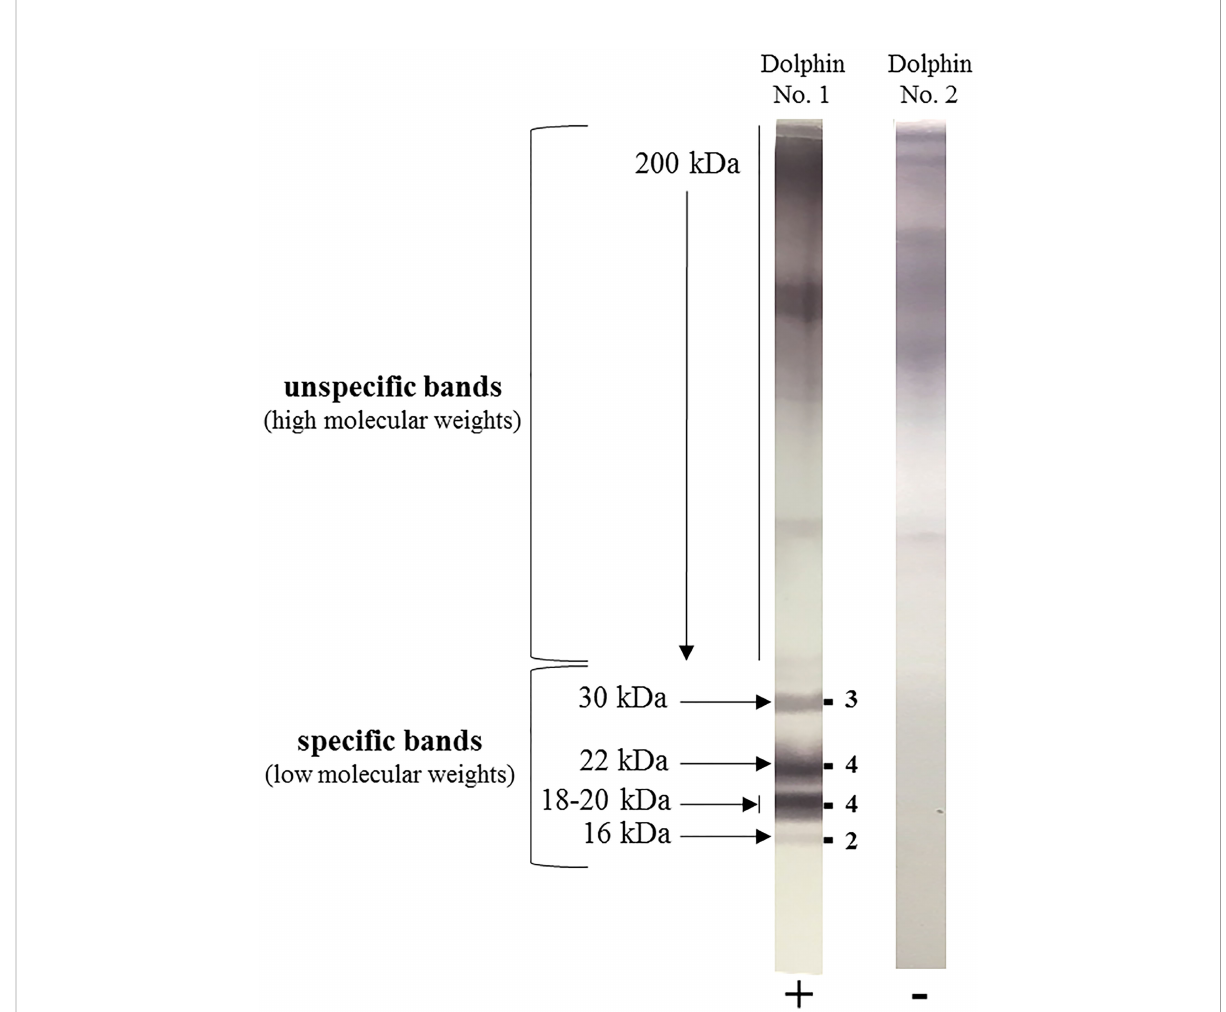
FIGURE 2 Example of two blood samples from common bottlenose dolphins ( Tursiops truncatus ) tested for anti- Aspergillus antibody by the Aspergillus Western blot IgG ® kit (LDBio Diagnostics, Lyon, France). Dolphin N°1 was found positive (+) with a global Western blot score of 13/16, as indicated on the right side of the immunoblot strip by the sum of the respective band intensities observed at 30, 22, 18-20 and 16 kDa. Dolphin N°2 was found negative